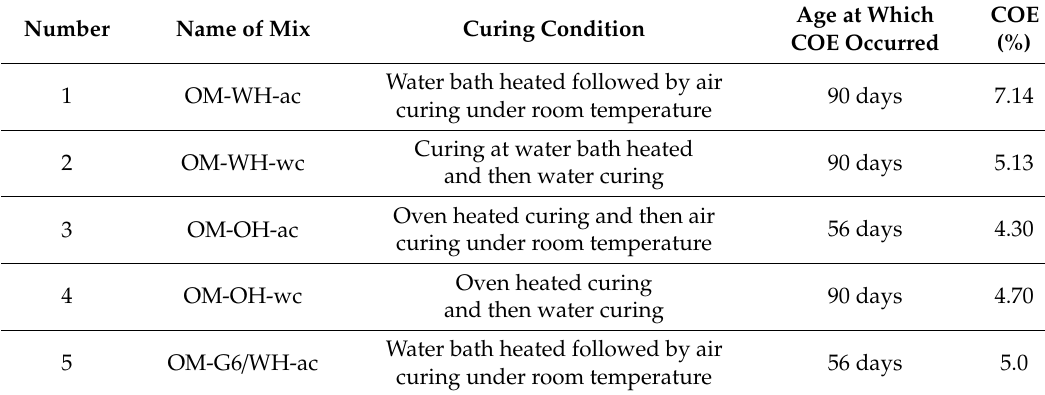
Table 1. Mix proportions of ordinary Portland cement (OPC) mortars in one batch, curing conditions and crossover e ff ect (COE)